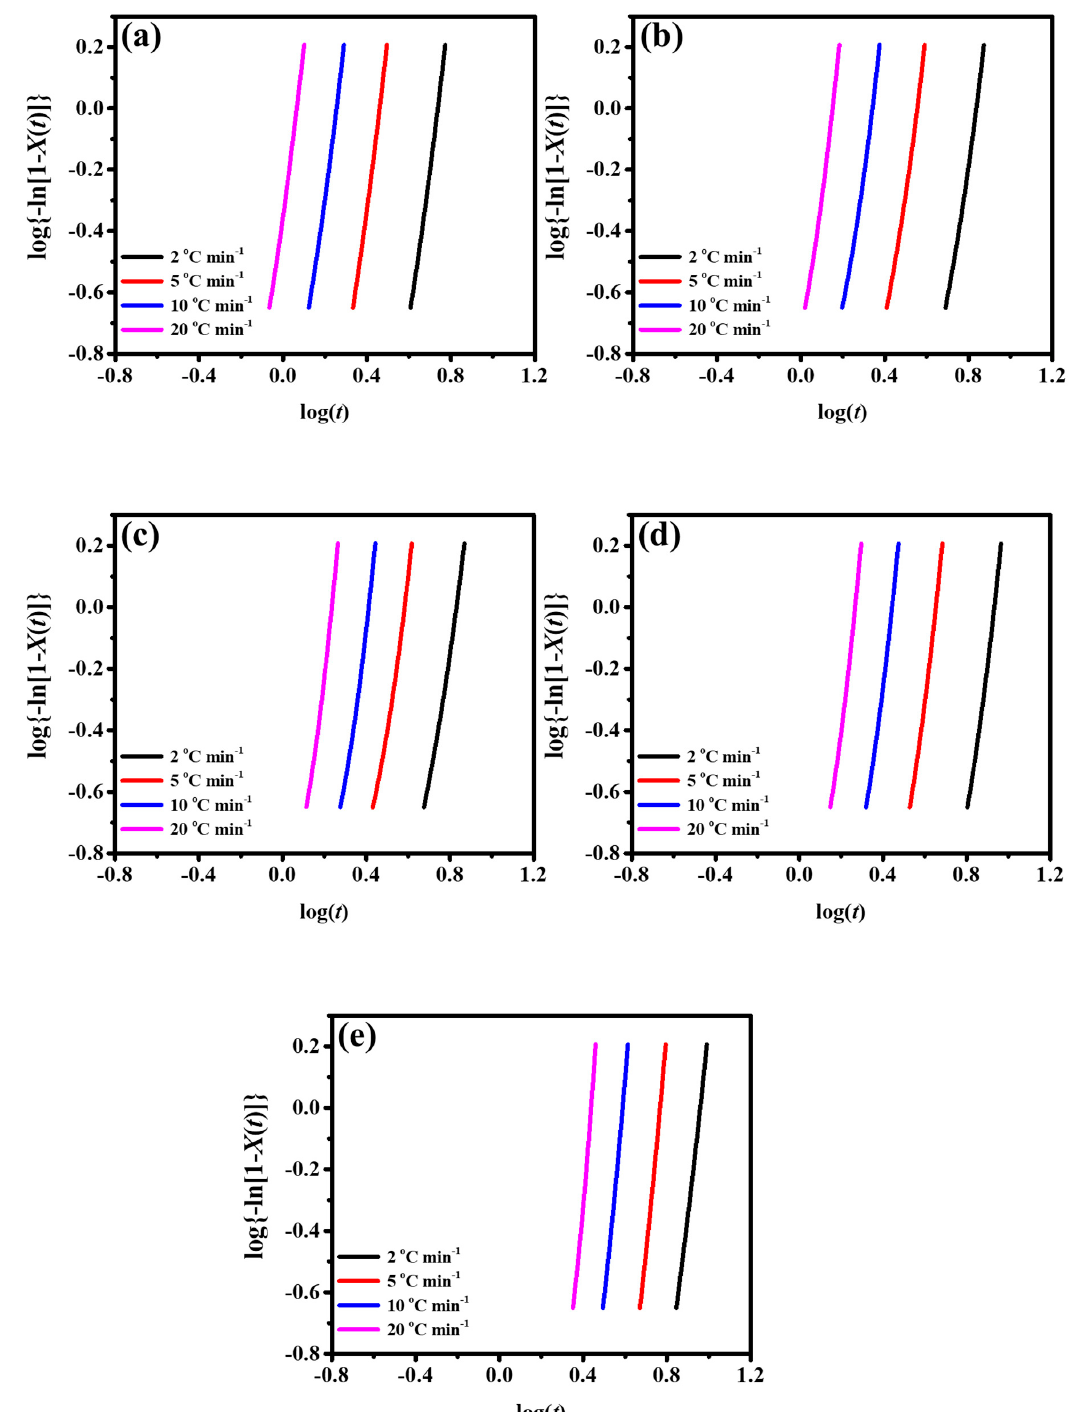
Figure 8. Avrami plots for PBT- co -PTMEG copolymers at different PTMEG contents of ( a ) PBT, ( b ) PBT- co -PTMEG-10, ( c ) PBT- co -PTMEG-20, ( d ) PBT- co -PTMEG-30, and ( e ) PBT- co -PTMEG-40 at various cooling rates.